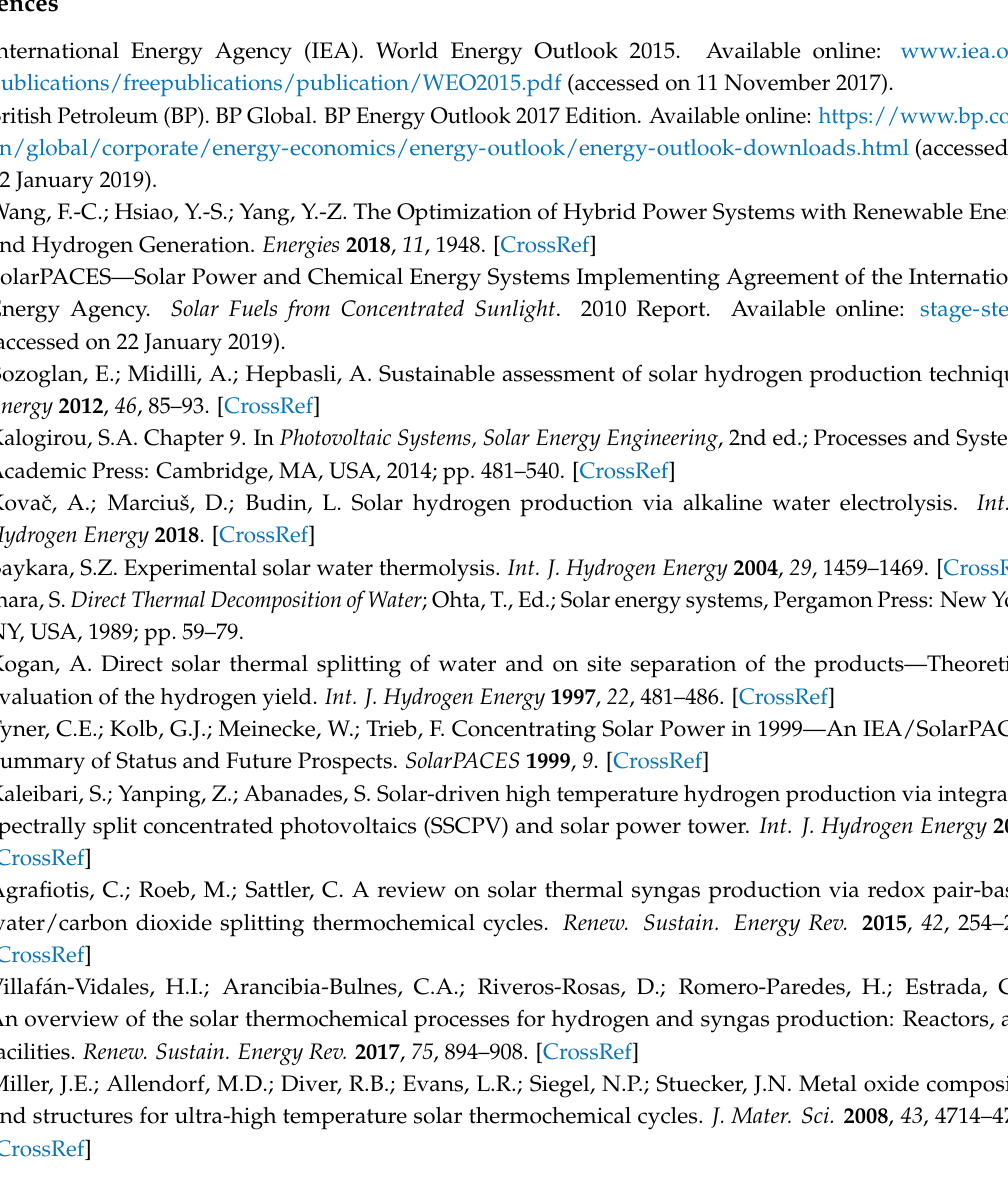
Figure A1. Sensitivity analysis of LHC (nickel-Ferrite, base case)